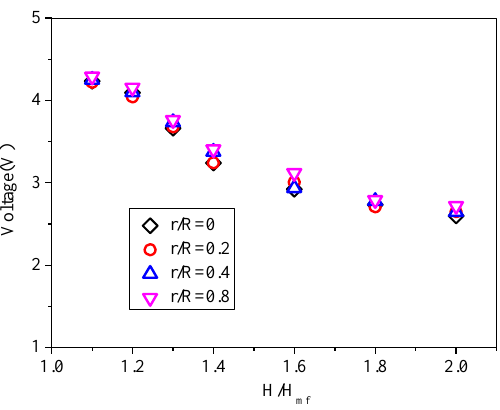
Figure 6. The probe output voltages of GB 3# at four different radial